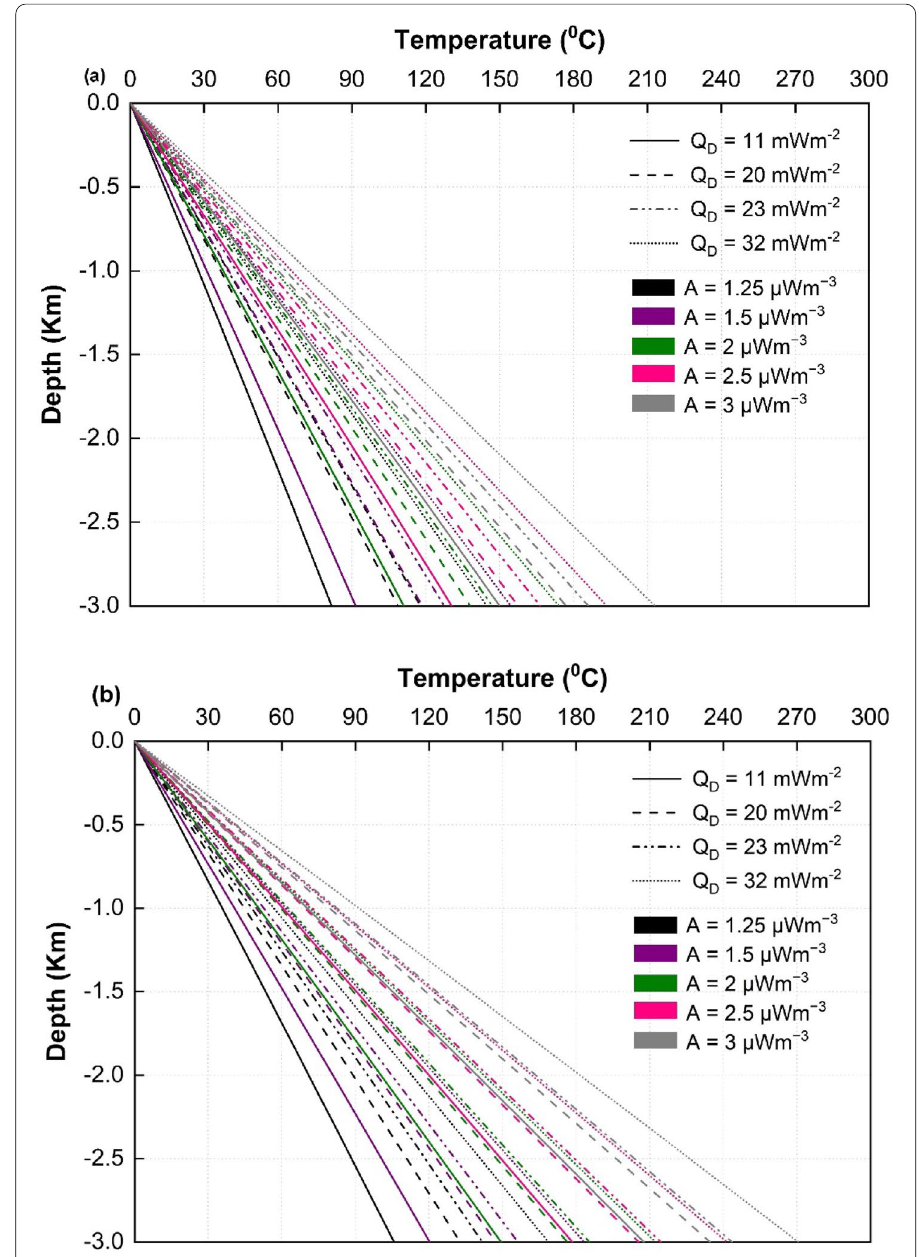
Fig. 11 Plot of one-dimensional equilibrium geotherms as calculated for crust up to 3 km depth for four different mantle heat flow values, and 5 different crustal heat production rates but considering two different crustal thicknesses: a for 34-km-thick crust, and b for 50-km-thick